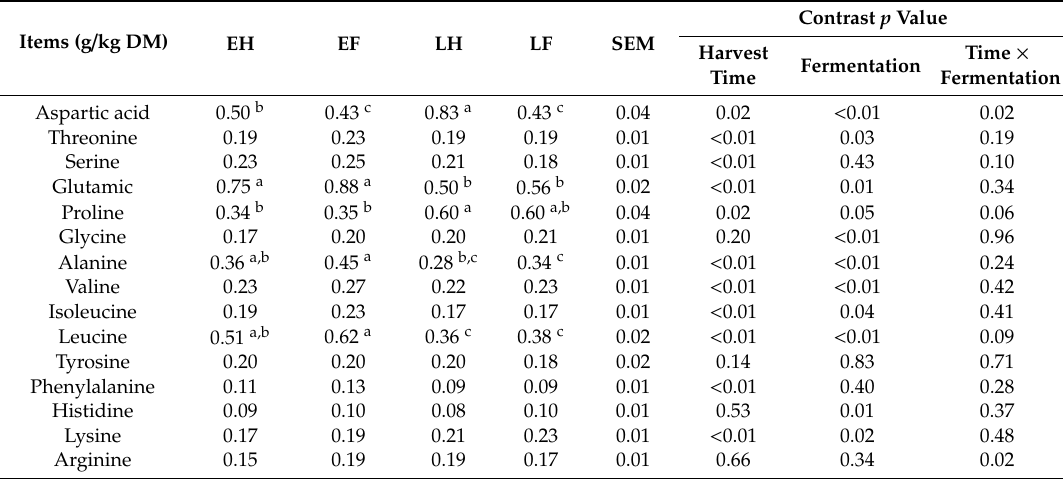
Table 4. E ff ects of harvest time and microbial anaerobic fermentation treatment on amino acid content of whole Zhang hybrid